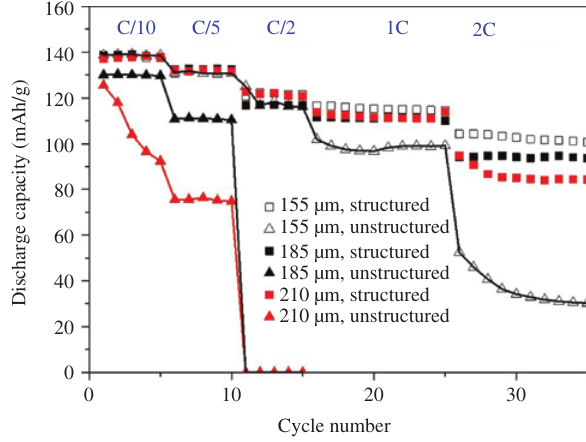
Figure 19: Specific discharge capacity as a function of cycle number for lithium-ion cells with structured and unstructured NMC-111 thick-film electrodes (film thickness: 155 μ m, 185 μ m, 210 μ m) for different discharge C-rates.